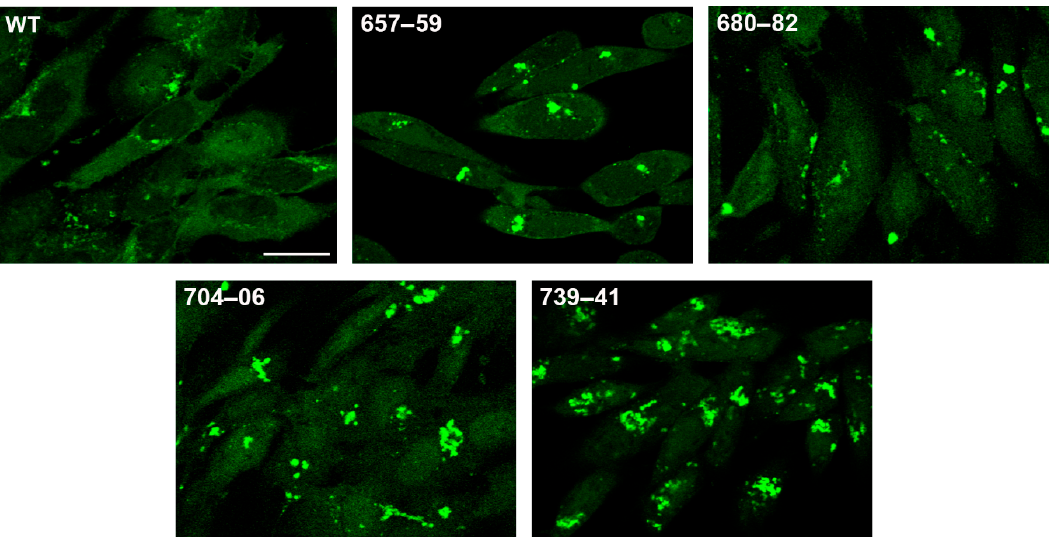
Figure 7. Deleterious pUL37 alanine substitution mutants accumulate GFP fluorescence at a juxtanuclear site. RPE-1 cells in chamber slides were infected with EGFP-tagged pUL37 mutants or wild-type at an MOI of 10 PFU/cell and analyzed by confocal microscopy at 12 h post-infection. The pUL37–EGFP alanine mutant polypeptides 657–59, 680–82, 704–06, and 739–41 are observed with intense fluorescent signals at a juxtanuclear site. Scale bar = 25 µm.